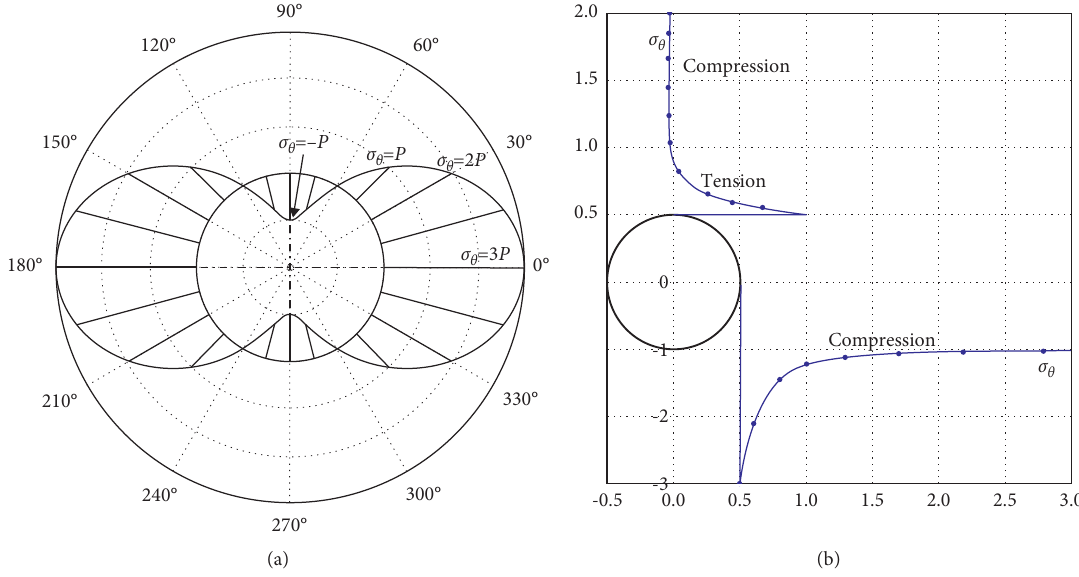
Figure 18: Static stress distribution (a) and stress transformation (b) [28] around the opening under uniaxial